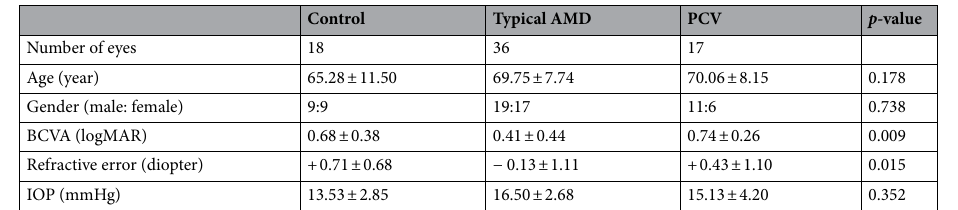
Table 1. Baseline demographics and characteristics of controls and patients with typical AMD and PCV. Analysis of variance (ANOVA) followed by Bonferroni post hoc test (age, BCVA) and χ 2 test (gender) were performed. Values are presented as the mean ± standard deviation. AMD age-related macular degeneration, PCV polypoidal choroidal vasculopathy, BCVA best-corrected visual acuity, logMAR logarithm of the minimum angle of resolution, IOP intraocular pressure.